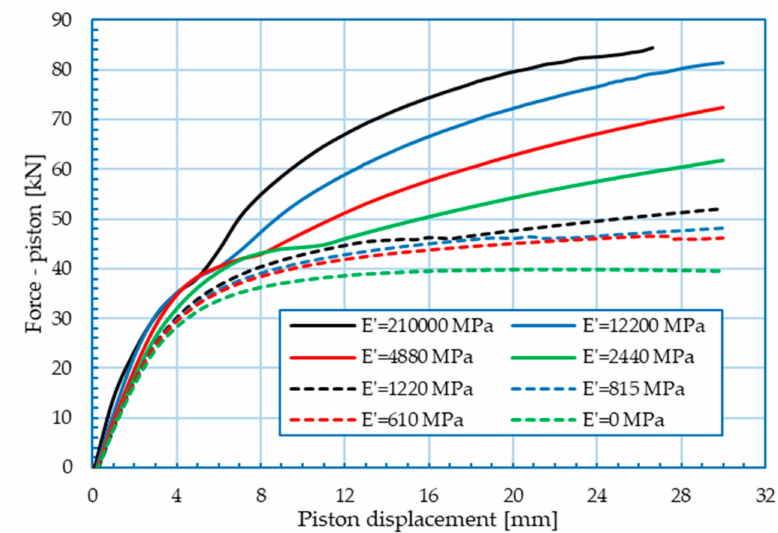
Figure 15. Force–piston displacement curves for different stiffnesses of the tie element.